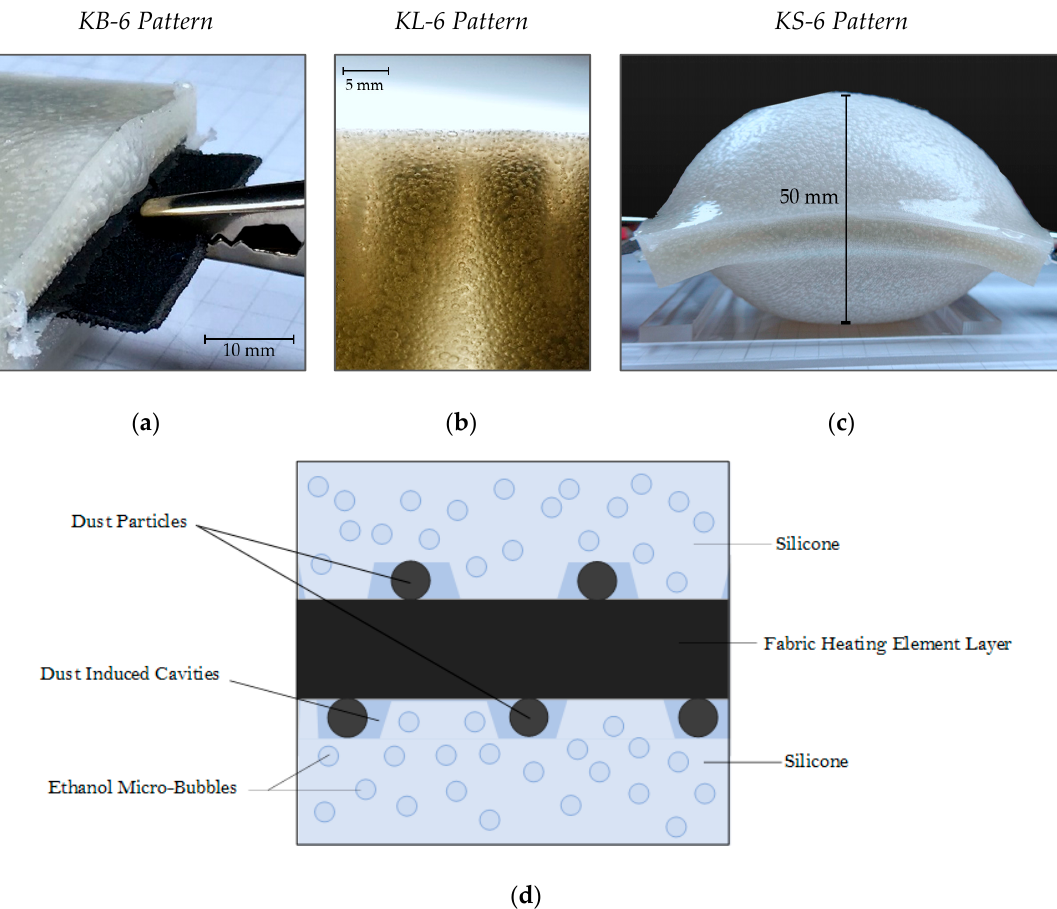
Figure 10. Observations from actuation. ( a ) KB-6 fully actuated, expanding the most around the alligator clips at the highest heat concentration. The falloff of the actuation is parallel to the falloff in heating, as seen in Figure 8d; ( b ) burnt-out KL-6 fabric heater embedded in actuated actuator; ( c ) actuated KS-6 actuator inflated to the shape similar to that of an overstuffed ravioli. Thickness of actuator increased by 500%, expanding from 10 mm to 50 mm; ( d ) cross-sectional view of ethanol actuator with fabric heater inside. Dust particles are shown to create large dust induced cavities. Size not to scale for clarity purposes.